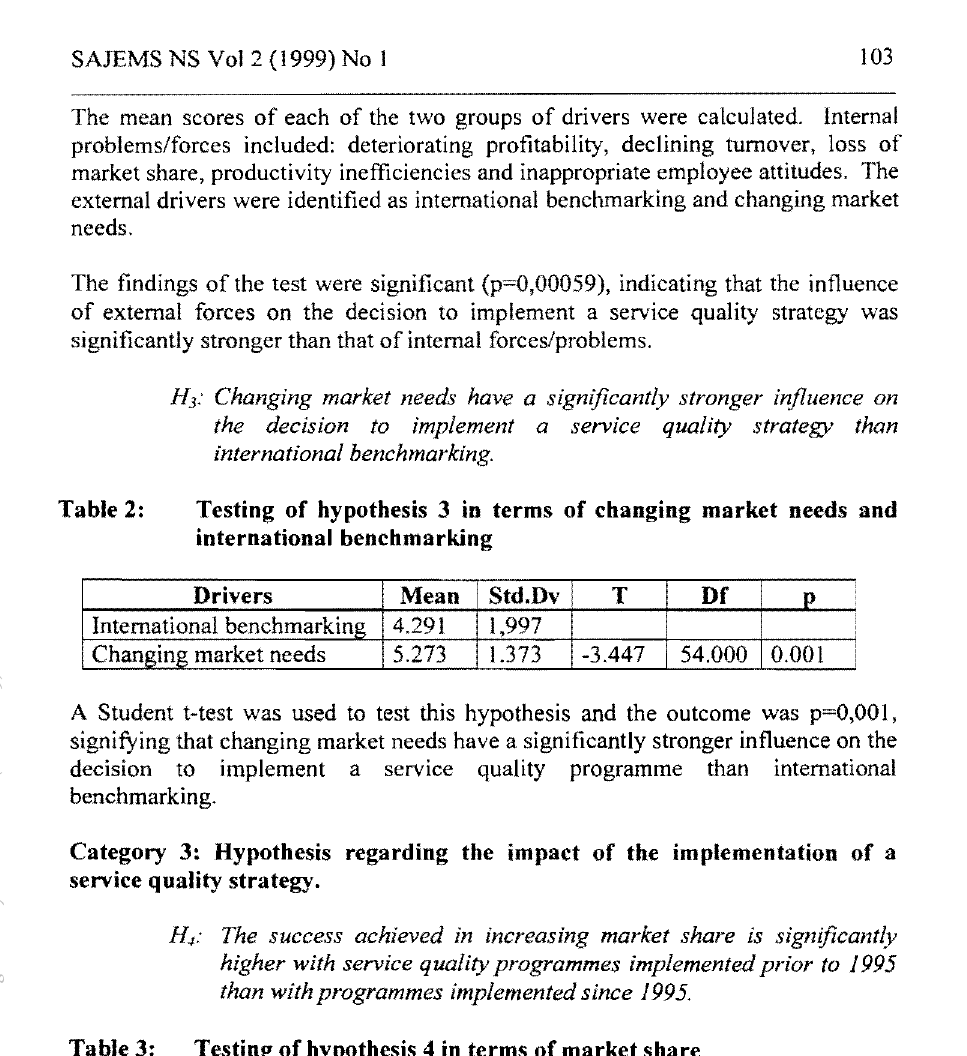
H 4: The success achieved in increasing market share is significantly higher with service quality programmes implemented prior to 1995 than with programmes implemented since